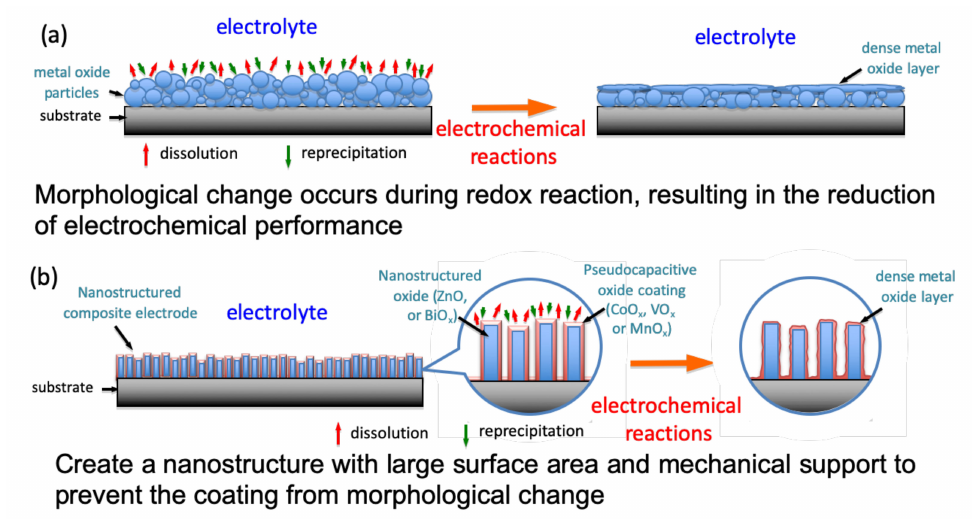
Figure 1. Schematic diagram of an electrochemical reaction between the surface of the pseudocapacitive material and the electrolyte solution. ( a ): Morphological change occurs during redox reaction, resulting in the reduction of electrochemical performance; ( b ): Creat a nanostructure with large surface area and mechanical support to prevent the coating from morphological